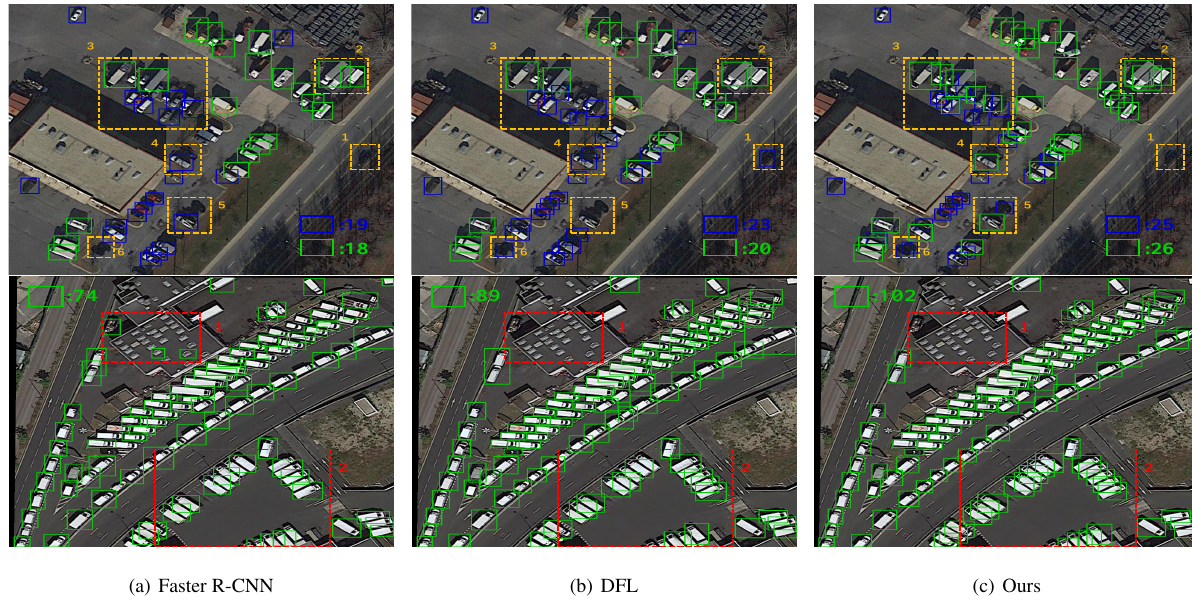
Figure 6. Qualitative comparison. Green boxes indicate detected large vehicles; blue boxes show detected small vehicles. The number of detected vehicles is shown at the bottom right. We use dashed red and yellow boxes to highlight challenging image parts, which can be handled correctly by our